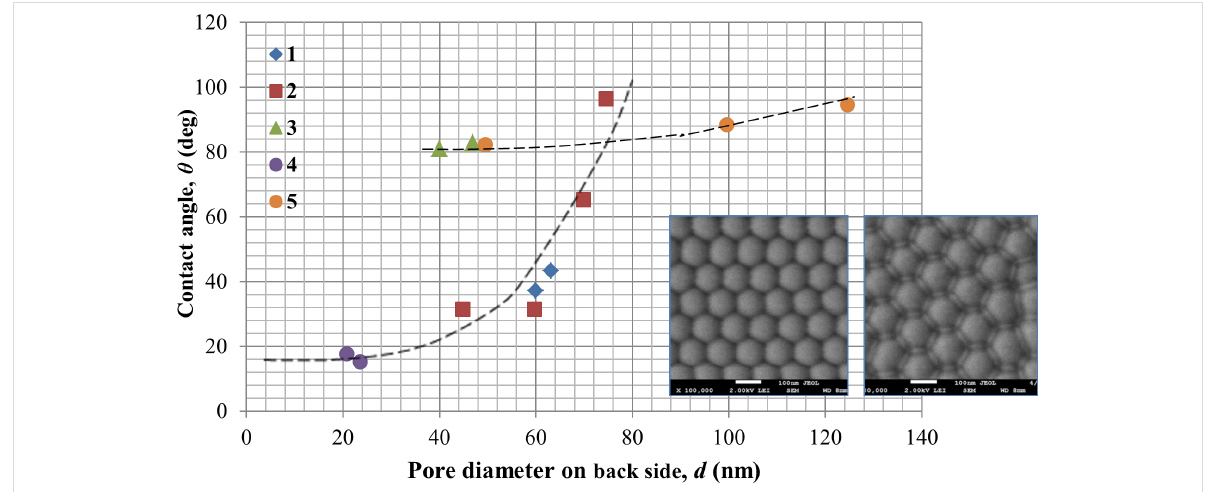
Figure 12: Contact angle measurements for the back side of the PAM as a function of pore diameter for various membrane thicknesses: 1 (blue diamonds) – 28 µm; 2 (red squares) – 45 µm; 3 (green triangles) – 65 µm; 4 (purple circles) – 75 µm; 5 – contact angle as a function of cell diameter for the as-made PAM (before pore opening). The inset shows SEM images of the back surface before (left) and after (right) chemical etching. The black dotted lines are polynomial fits shown as a guide to the eye for selected data